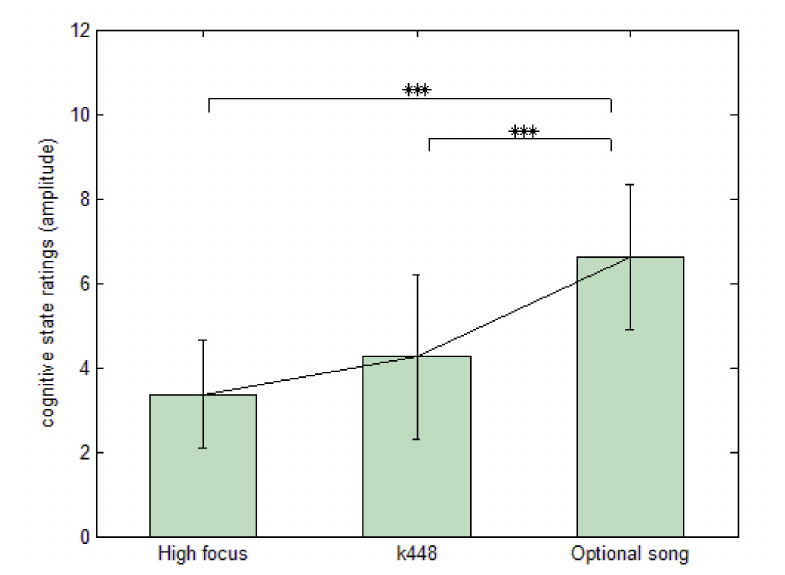
Figure 4. Self-rating of cognitive state, analysed by repeated-measures one-way ANOVA for inde- pendence; ***: p < 0.001.